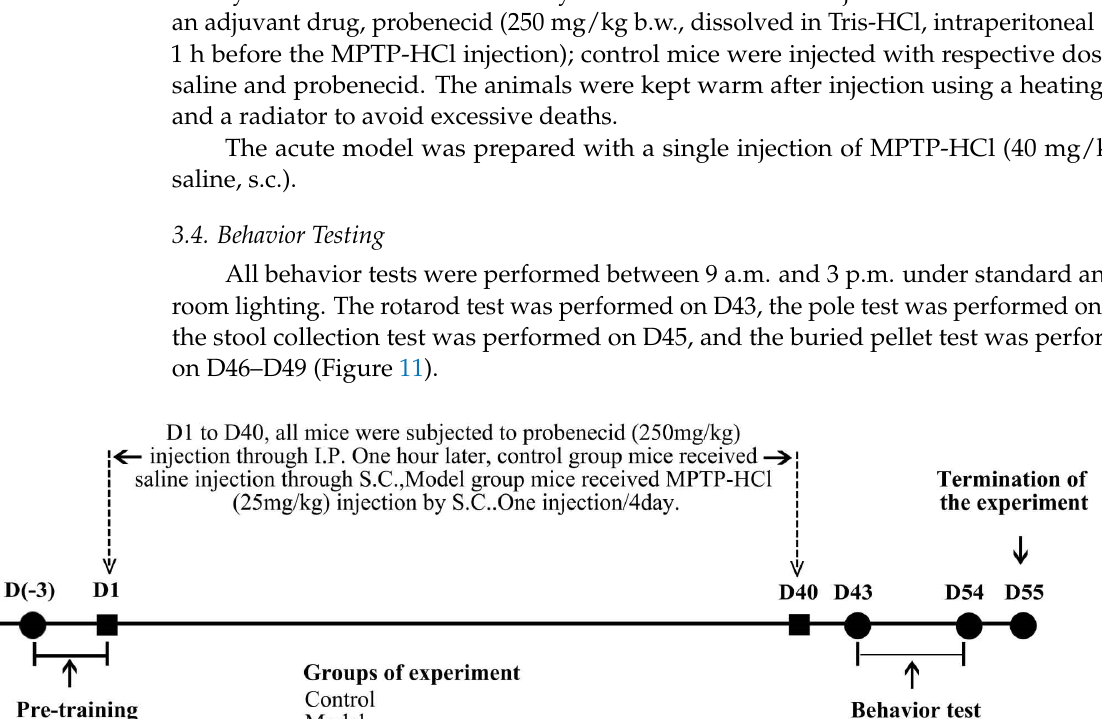
Figure 11. Schematic of the experimental procedure.